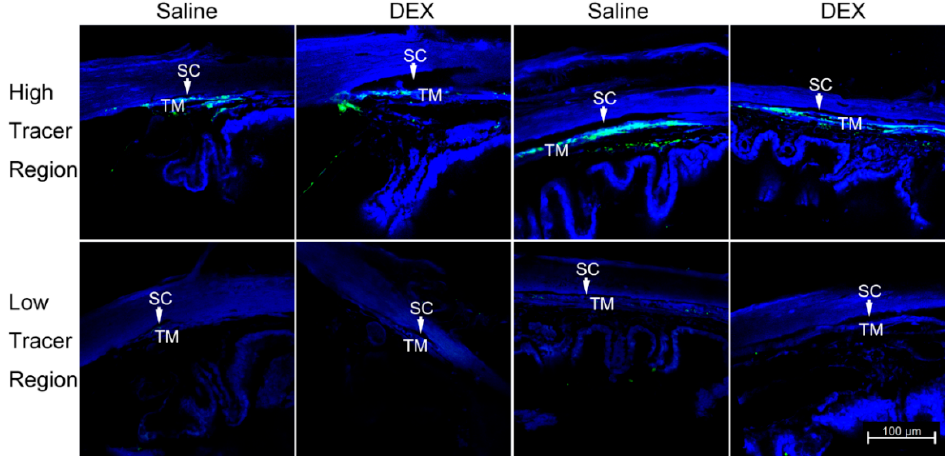
Figure 3. Tracer Distribution in the TM. Representative confocal images from radial ( left two panels) and frontal ( right two panels) plane views reveal the green tracer distribution in the high-tracer ( top panels) and low-tracer ( bottom panels) regions of the trabecular meshwork (TM). The blue represents DAPI staining for nuclei. DEX: dexamethasone; SC: Schlemm’s